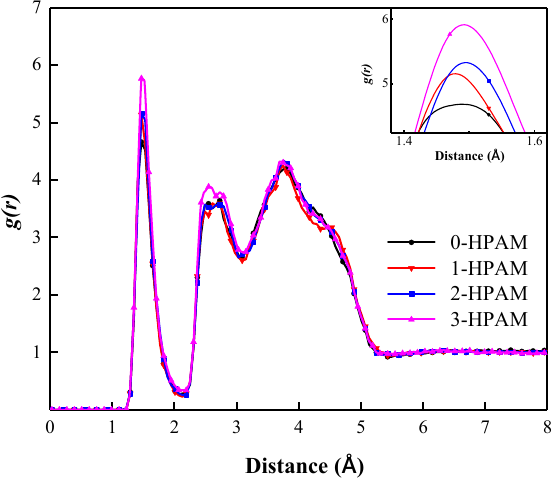
Figure 19. Radial distribution functions of SDBS head groups and surrounding water molecules in foam systems with different HPAM concentrations.